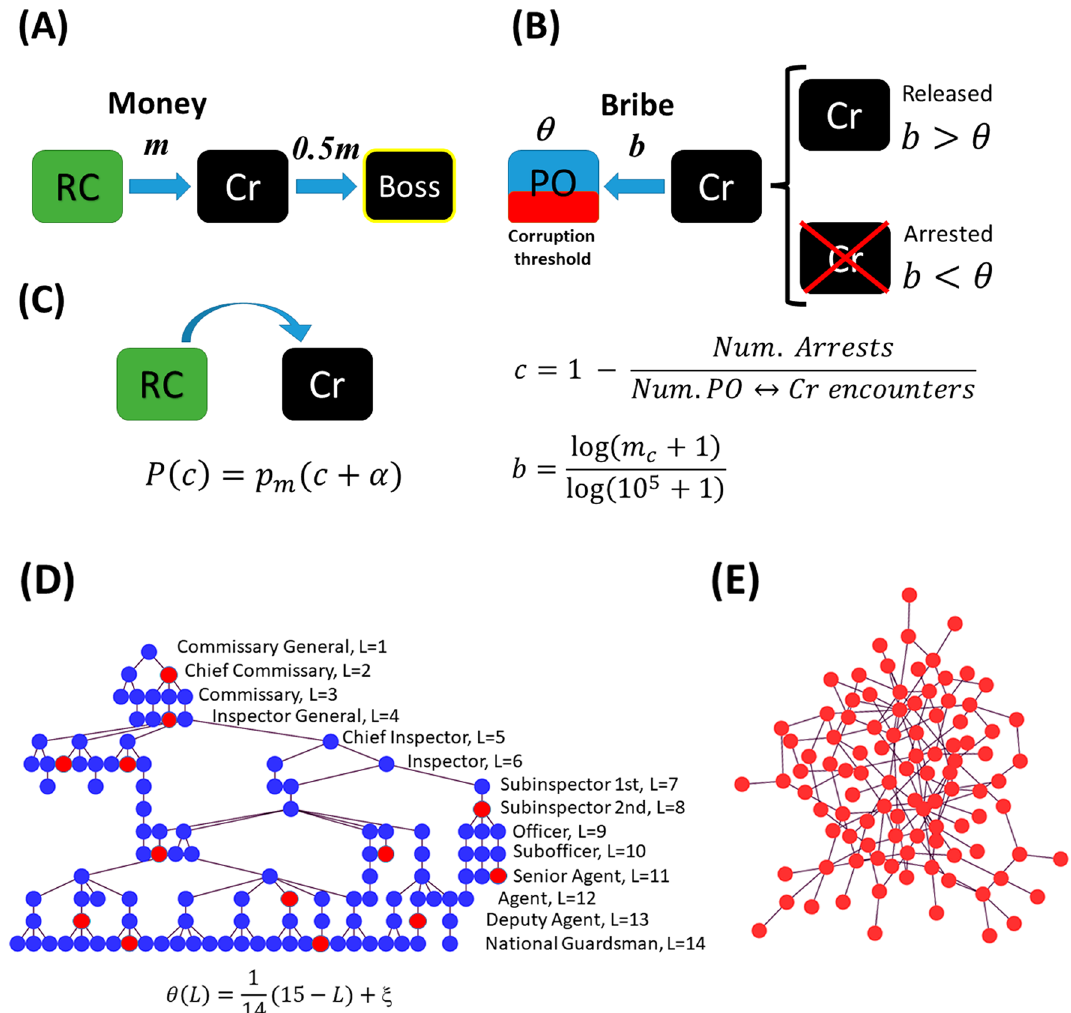
Figure 3. Agent-based model dynamics. ( A ) When a criminal (Cr) meets a regular citizen (RC), the criminal steels all the citizen’s money. The criminal then gives 50% of the stolen money to his boss (another criminal). ( B ) Police officers (PO) are characterized by a corruption threshold θ . In a PO ↔ Cr encounter, the criminal offers a bribe b to the officer. If the bribe is larger than the officer’s corruption threshold, the criminal is released, otherwise he is arrested and disappears from the simulation. The corruption level c is a function of the ratio between the number of arrests and the total number of PO ↔ Cr encounters. ( C ) A RC has a probability P ( c ) of turning into a Cr. The turning probability P ( c ) is higher as the actual level of corruption level c increases. The parameter p b = p m α represents the increase perception of corruption and p m is a parameter that limits the maximum level of the citizen → criminal turning probability. ( D ) Schematic representation of the police network. The 14 ranks and their corresponding levels are indicated. The corruption threshold θ of the corrupt officers (represented by red circles) is a linear function of the level L , plus a small noise ξ . ( E ) Schematic representation of the criminal network, which is constructed through a preferential attachment algorithm based on money rather than on the number of connections: when a regular citizen becomes a criminal, he has to work for a boss chosen with a probability proportional to the boss’